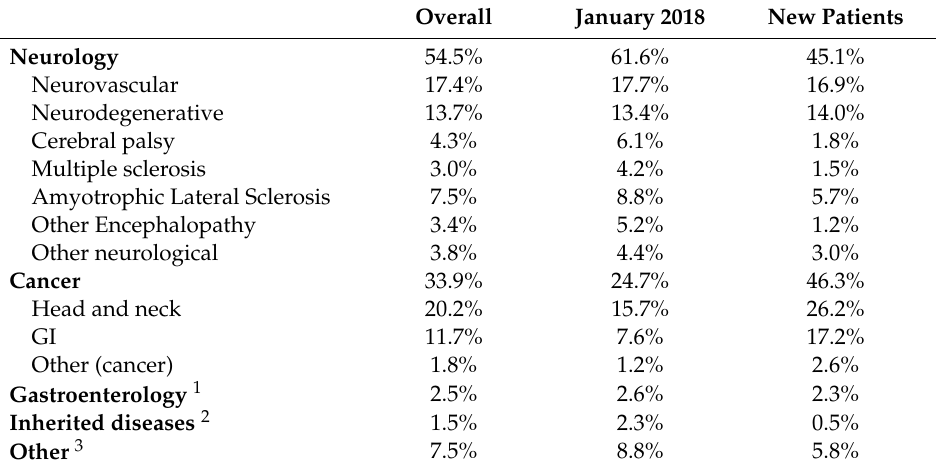
Table 2. Primary diagnosis.